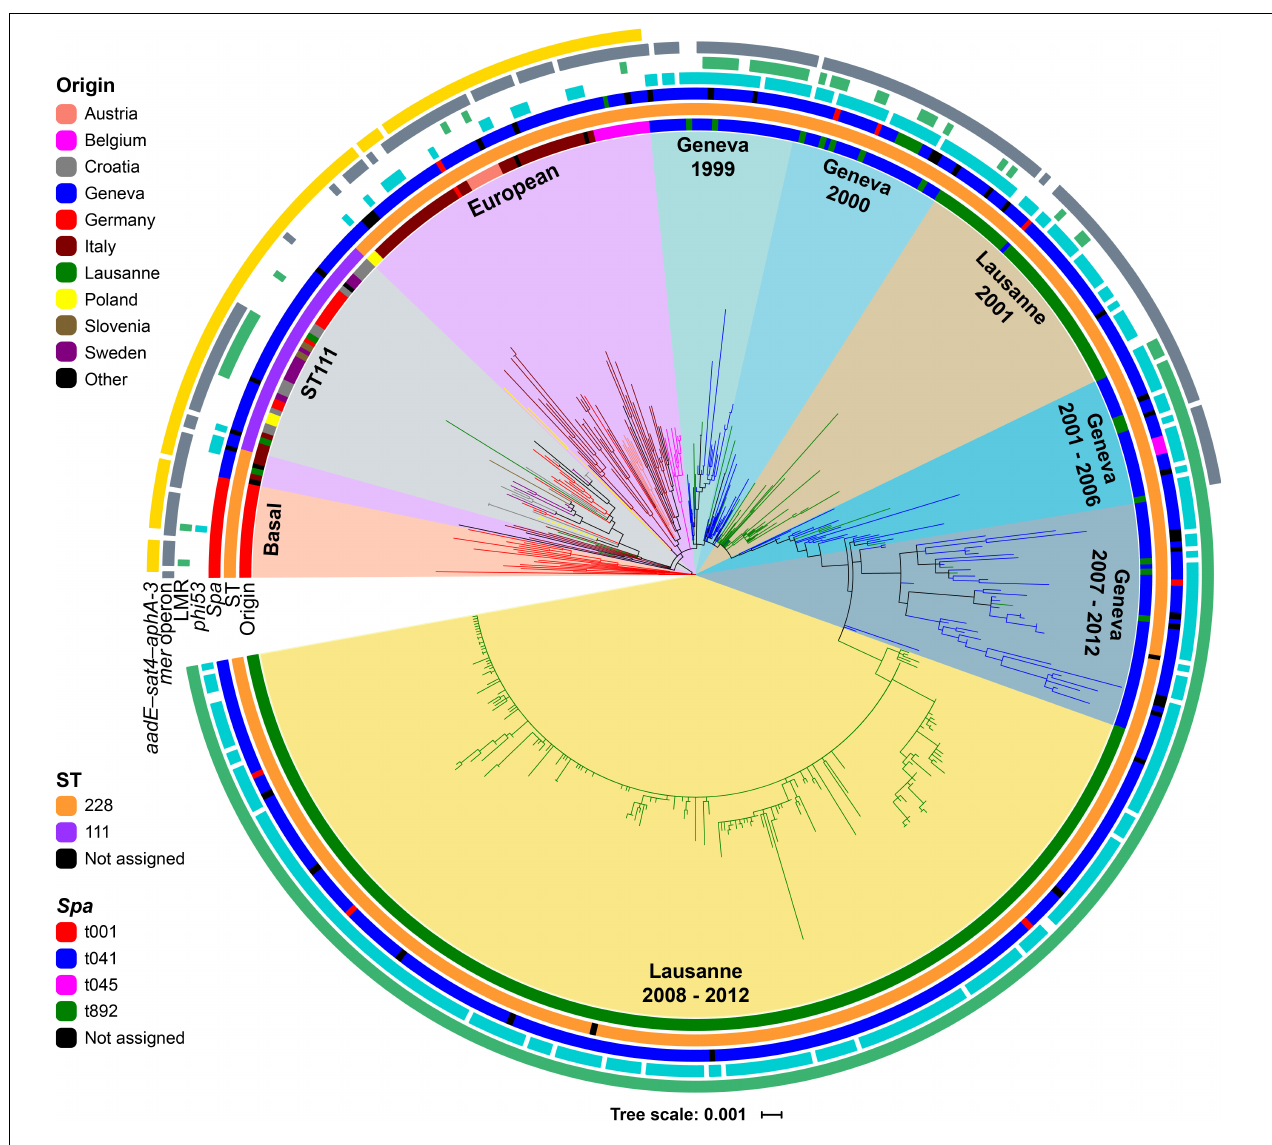
FIGURE 1 | Rooted maximum likelihood (ML) phylogenetic tree of the 530 ST228 ( n = 485) and ST111 ( n = 43) MRSA isolates based on 3,899 core-genomes SNPs. The tree was rooted by using the distantly related S. aureus N315 as an outgroup. Branch colors represent country/cities of isolation. Rings from inner to outer; first ring ( Origin ) represent the geographical origin, second ring ( ST ) is assigned to the different STs, third ring ( spa ), fourth ring ( phi53 ) detected, fifth ring ( LMR ) mutation responsible for the low level mupirocin resistance phenotype, sixth ring ( mer operon ) shows the isolates harboring the mercury operon gene cluster, and seventh ring ( aadE-sat4-aphA-3 ) represents the acquisition of the gene